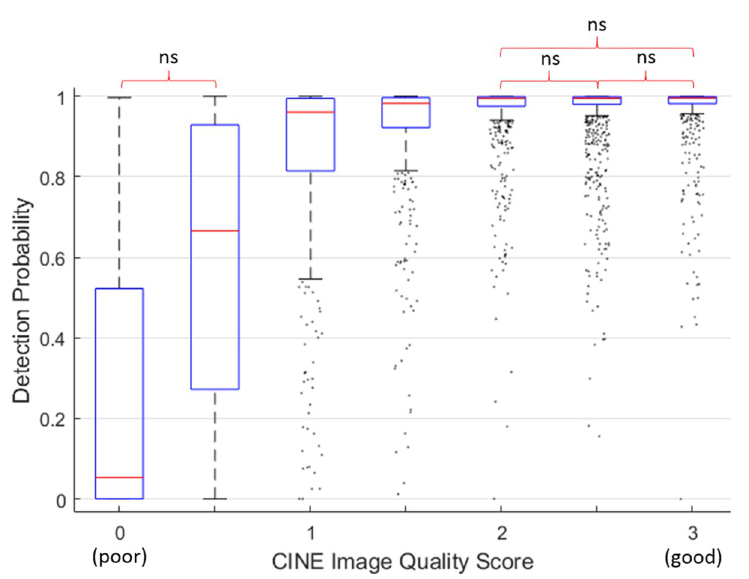
Fig 10. Automated AA × PDA detection probability grouped by CINE image quality (IQ). Total number of scans in the test dataset = 3900. The difference among the highest IQ groups and between the 2 lowest IQ groups is not significant